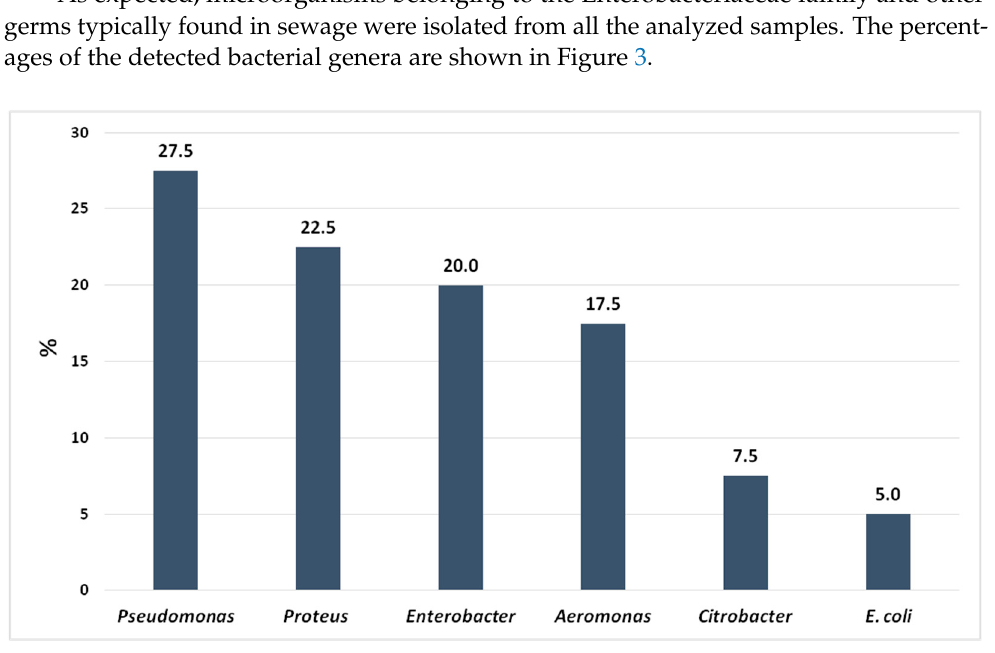
Figure 4. General percentage resistance of the detected bacterial strains to the used antibiotic fami- lies.